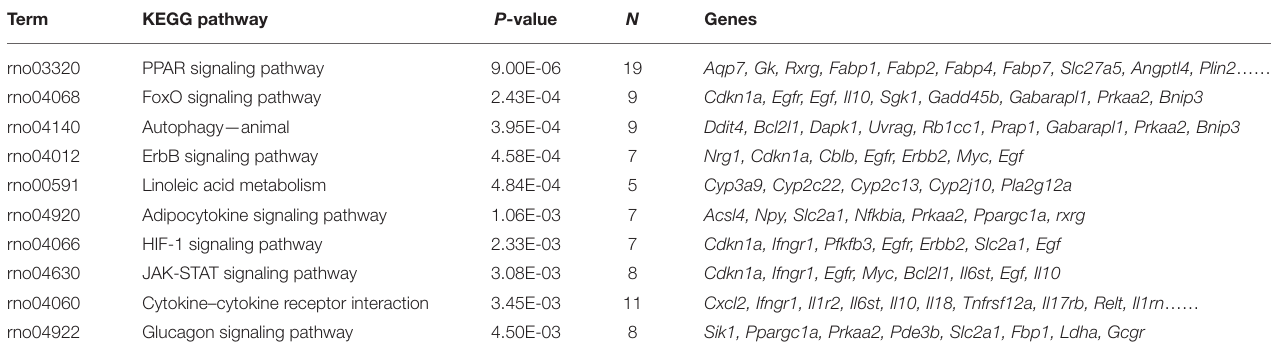
TABLE 3 | The core pathways analysis for DEGs between IUGR and